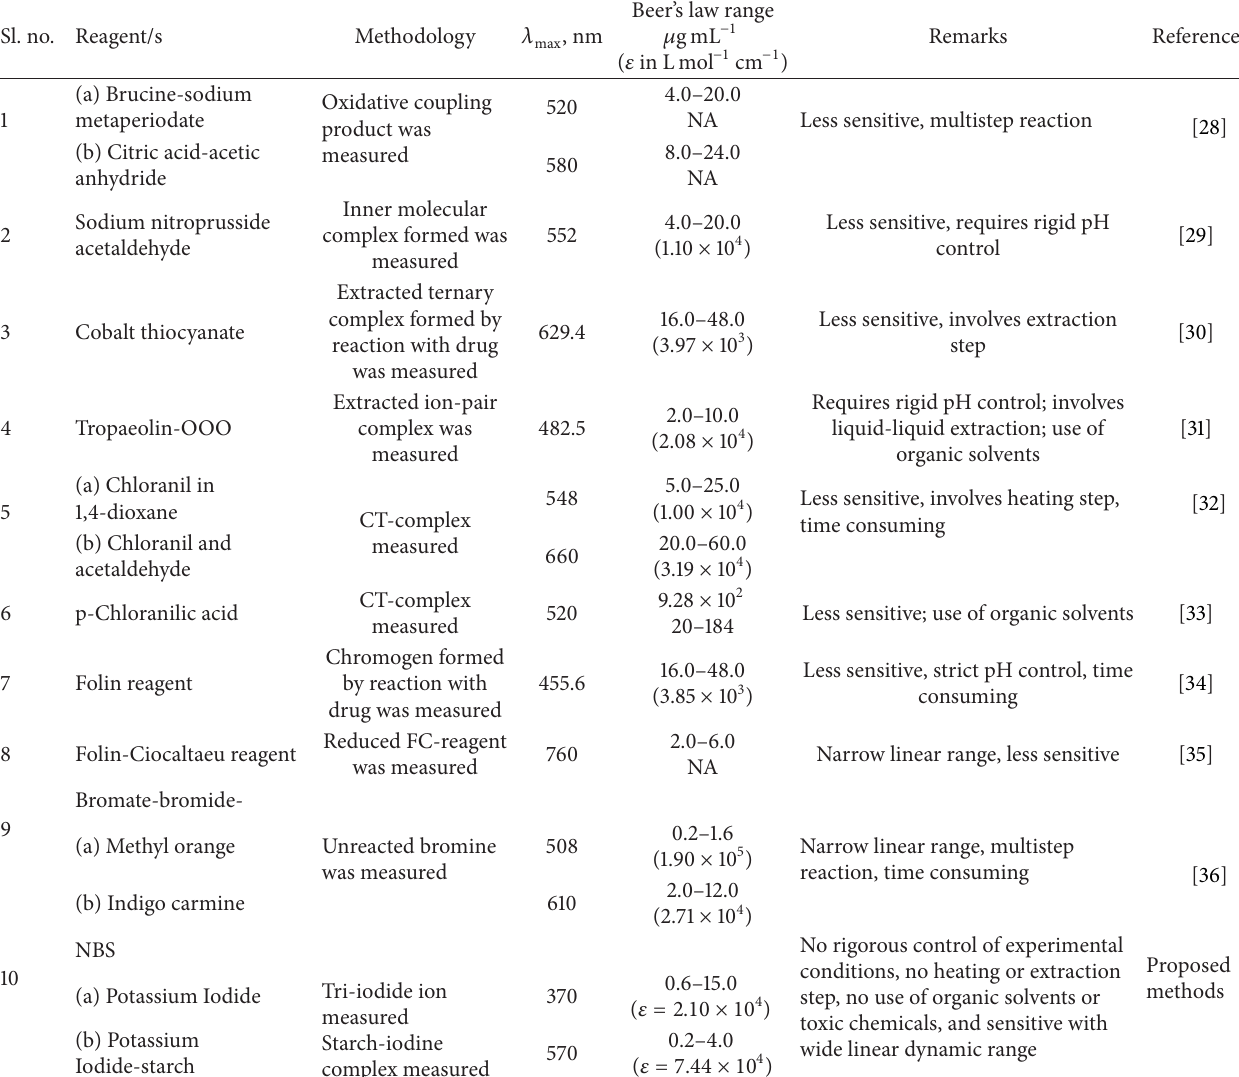
Table 1: Comparison of the proposed and the existing visible spectrophotometric